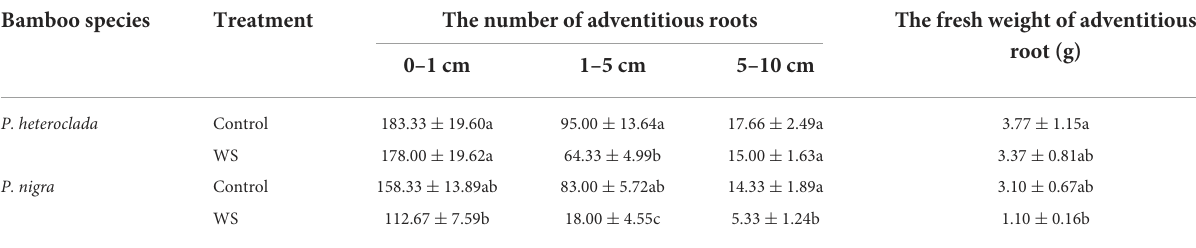
TABLE 1 Effects of waterlogging treatment on the root characteristics of Phyllostachys heteroclada and P. nigra under waterlogging conditions. Bamboo